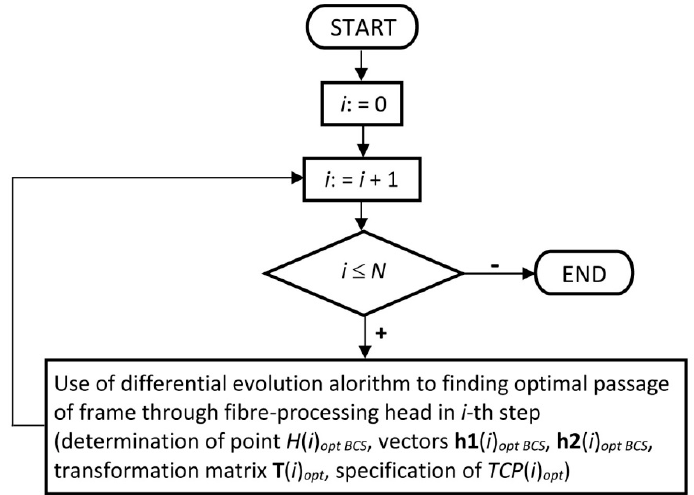
Figure 12. Flowchart of optimal off-line REE trajectory calculation.